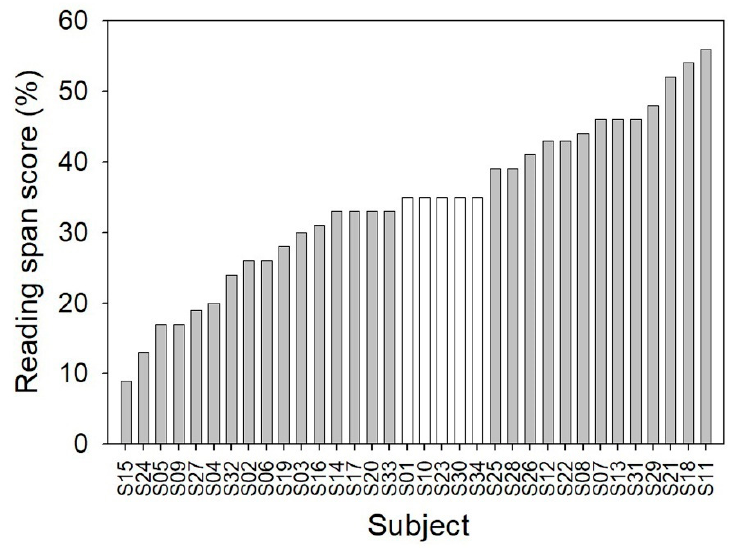
Figure 3. Reading span scores for all 34 participants (S01 to S34). For other analyses presented later, two cognitive performance groups were created by excluding the five participants with their reading span scores of 35 (white bars). Among the remaining 29 participants (gray bars), those whose reading span scores were lower than 35 were considered cognitively low-performance participants (16 participants), and those whose reading span scores were higher than 35 were considered cognitively high-performance participants (13 participants).